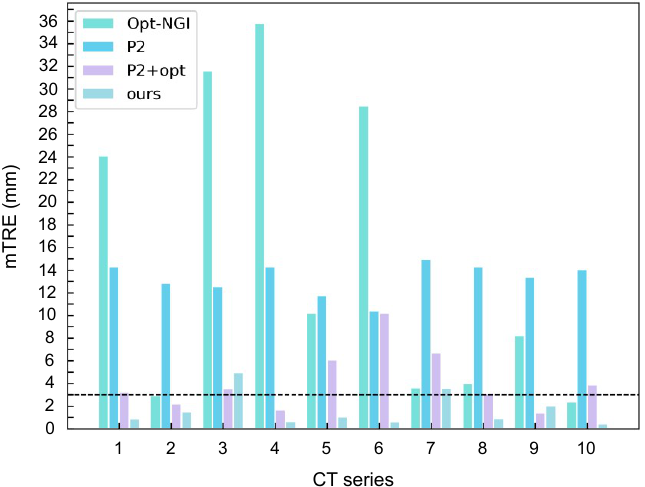
Figure 8. The mTRE of three methods for ten test cases. The criterion of a successful registration is mTRE < 3 mm.